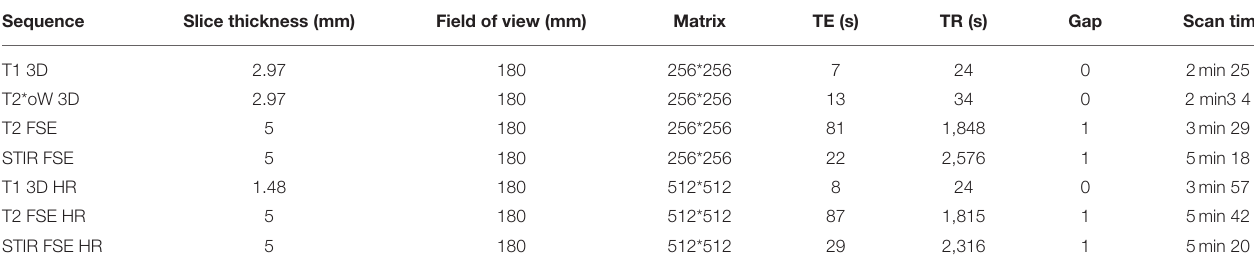
TABLE 1 | Standing magnetic resonance acquisition parameters. Sequence Slice thickness (mm) Field of view (mm) Matrix